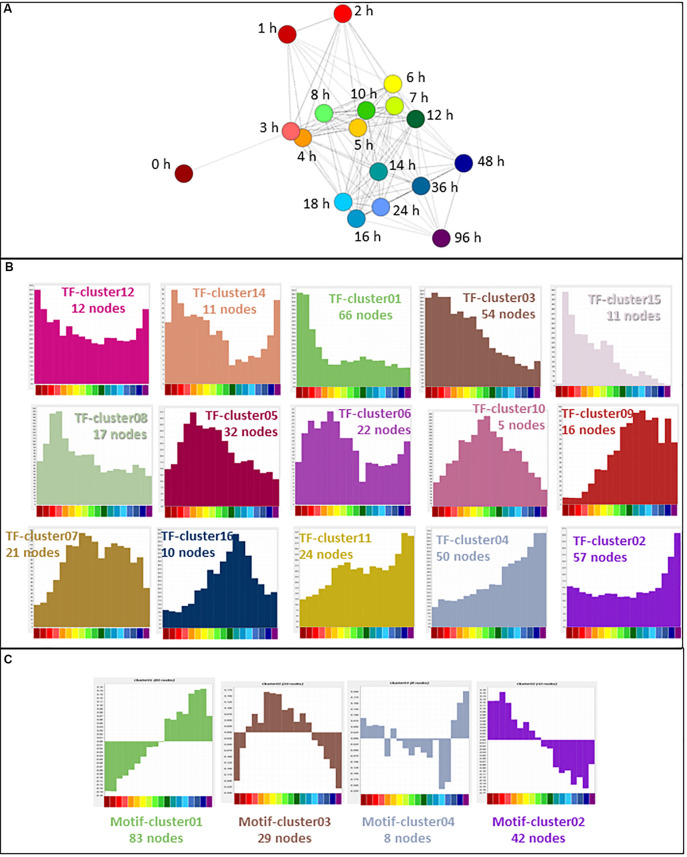
Expression of transcription factors during THP-1 differentiation. (A) Sample-to-sample analysis of 647 curated transcription factors (796 TSS) (Lambert et al., 2018) expressed during THP-1 differentiation. Edges show correlations of ≥0.61. Hours after addition of PMA are indicated. (B) Expression profiles of clusters generated by gene-to-gene analysis of curated transcription factors. Averaged values for each time point. Correlation coefficient was of ≥0.85 and MCL inflation value was 1.7. (C) Network analysis of transcription factor motif activity. Histograms showing average activity (as detected by MARA) of transcription factor motifs, clustered at a correlation coefficient of ≥0.60 and MCL inflation value of 1.7. Color code for the X axis is as for Figure 2.